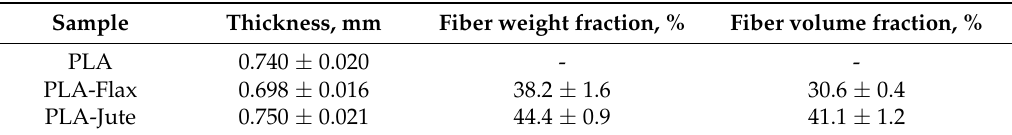
Table 4. Thickness and fiber fractions of the